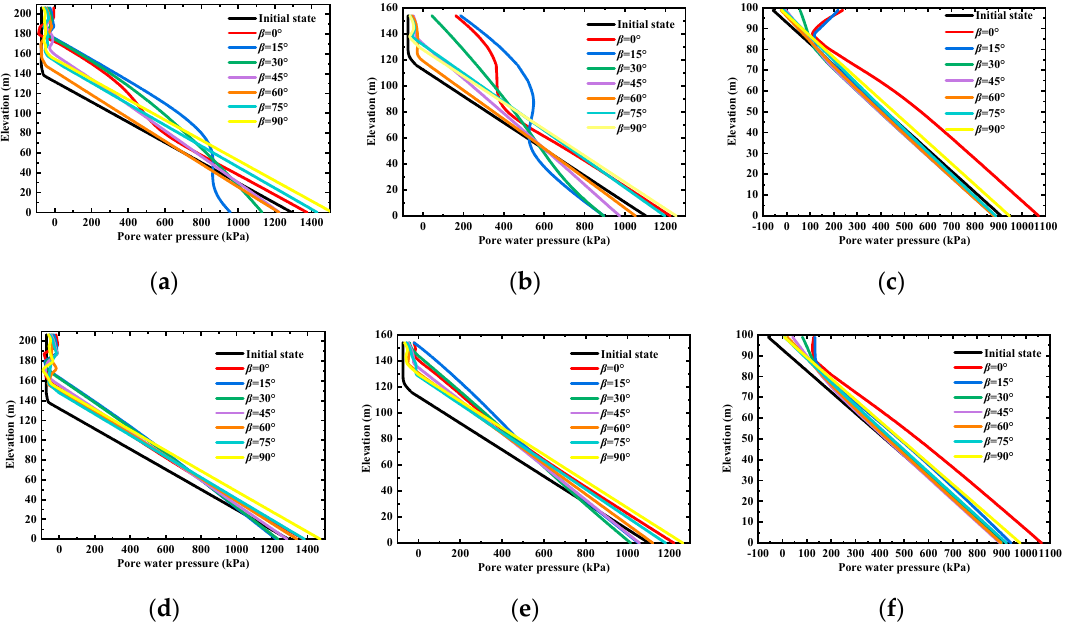
Figure 11. Pore water pressure levels at different positions on the layered rock slope under different β values with kr = 0.01 and kr = 0.1: ( a ) Top of the slope with k r = 0.01; ( b ) middle of the slope with k r = 0.01; ( c ) middle of the slope with k r = 0.01; ( d ) top of the slope with kr = 0.1; ( e ) middle of the slope with kr = 0.1; ( f ) bottom of the slope with kr = 0.1.